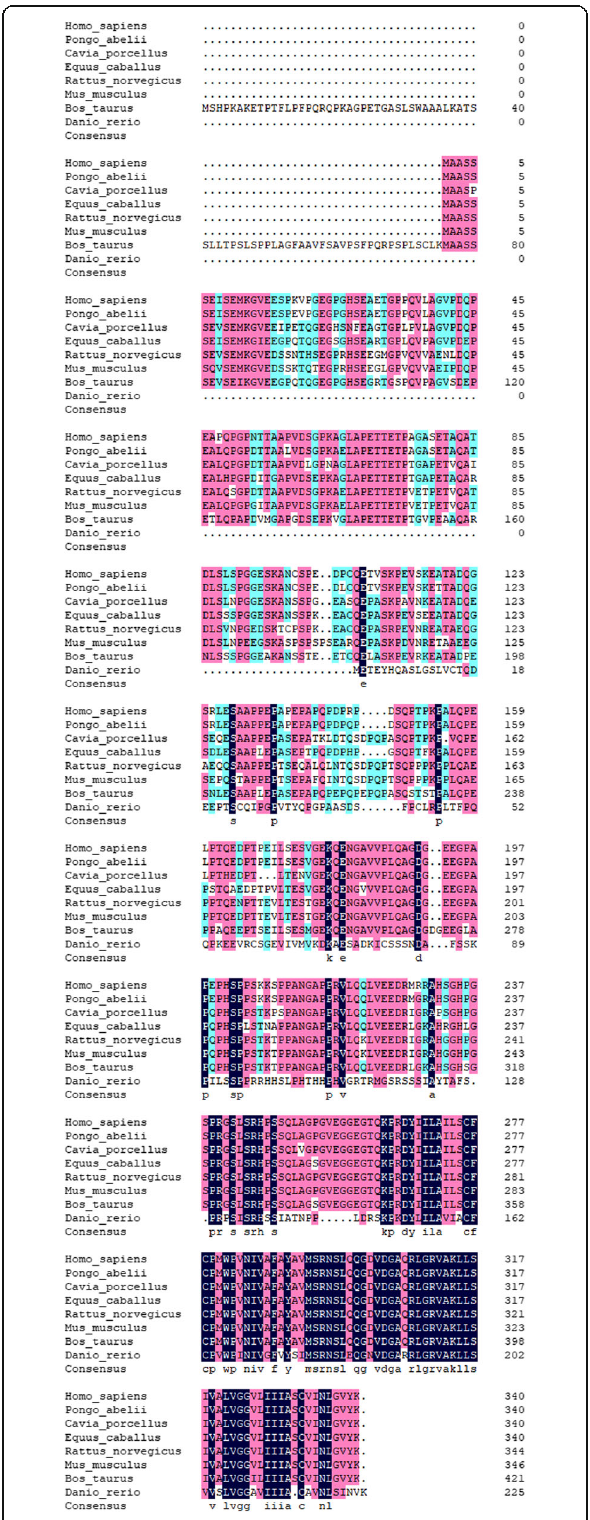
Fig. 1 Homology comparison of the amino acid sequences of PRRT2 proteins in different